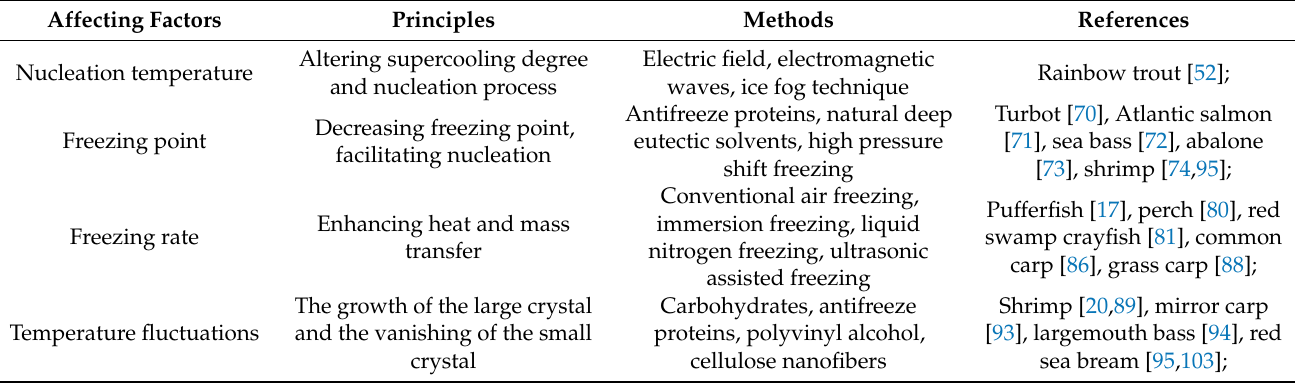
Table 1. Affecting factors and control technology of ice